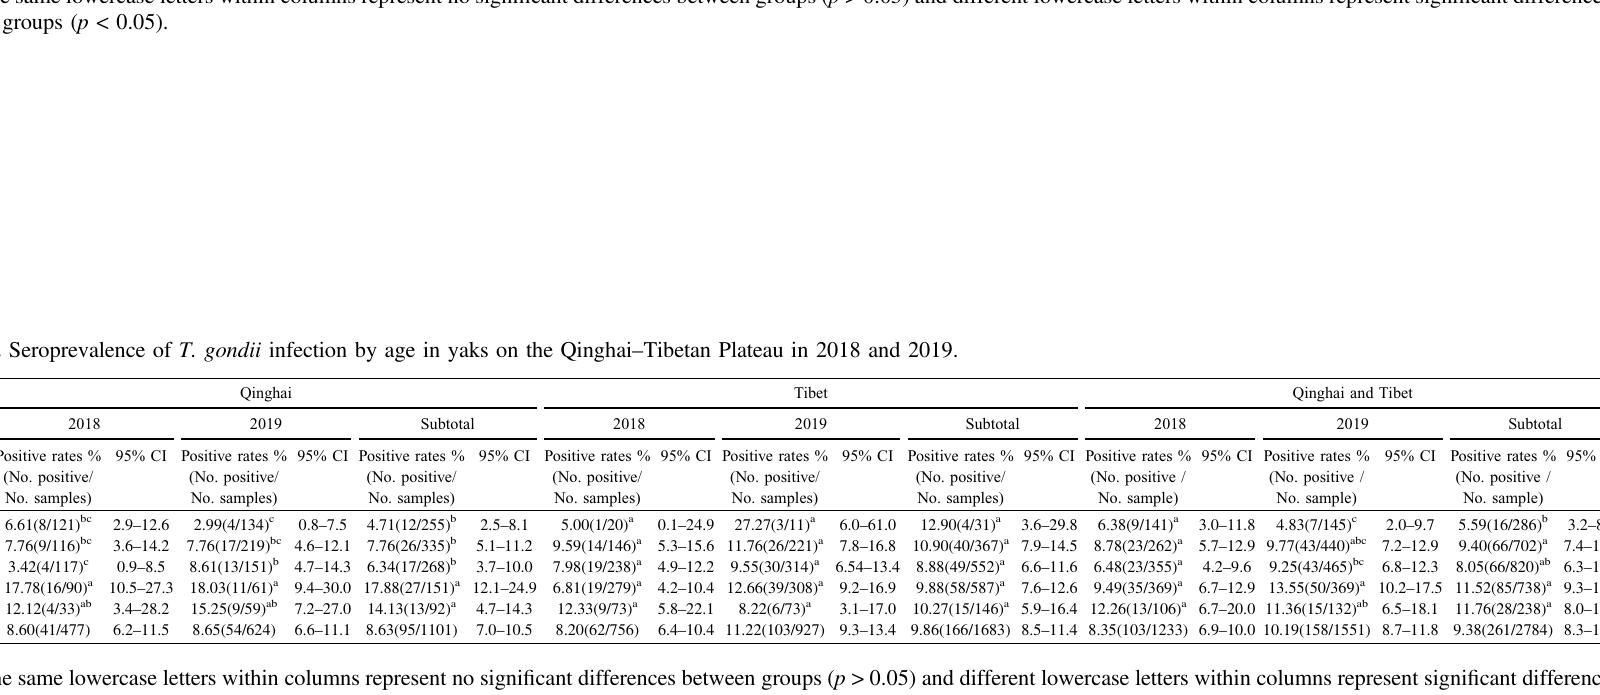
Note: The same lowercase letters within columns represent no signi fi cant differences between groups ( p > 0.05) and different lowercase letters within columns represent signi fi cant differences between groups ( p <